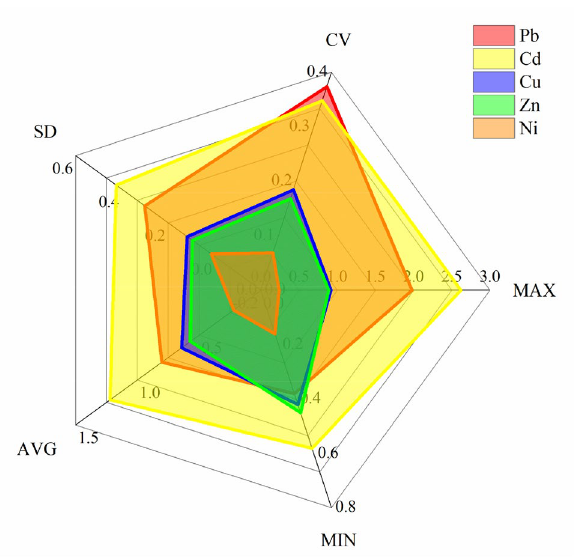
Figure 9. Evaluation results of single factor pollution index method.